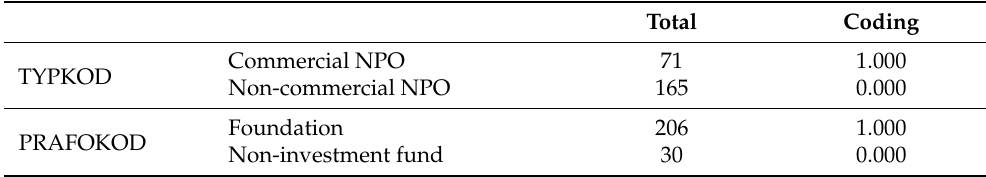
Table 2. Dichotomous (independent)